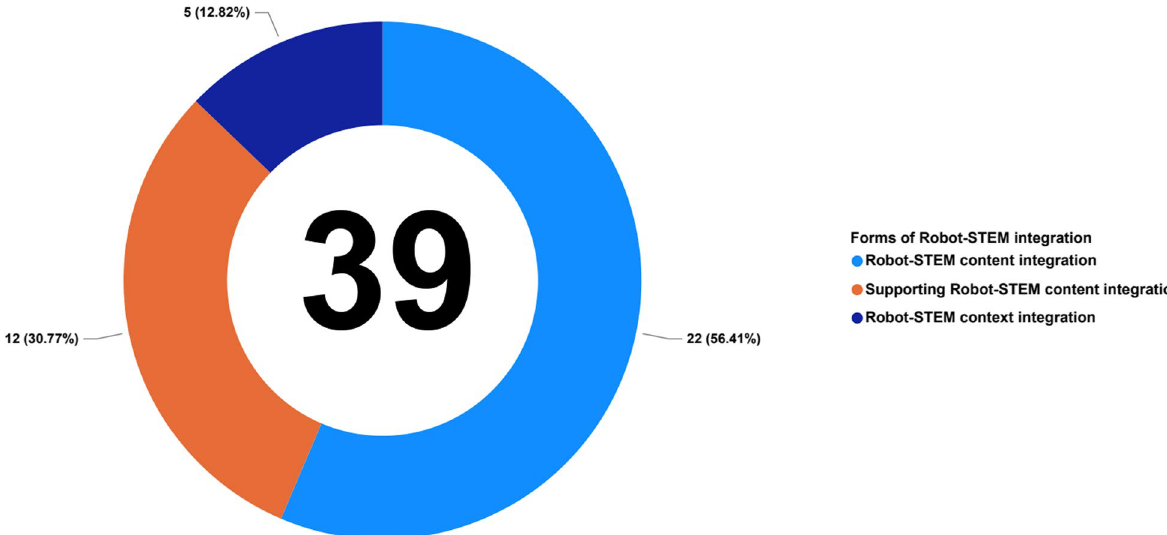
Fig. 11 The forms of robot‑STEM integration